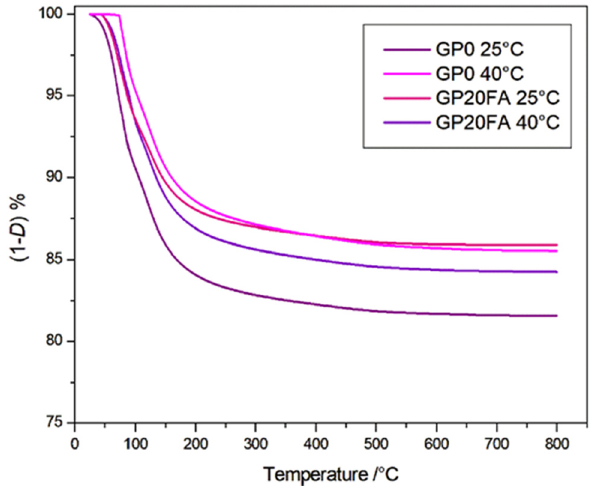
Figure 5: TG degradation curves, in static air atmosphere, for GP0